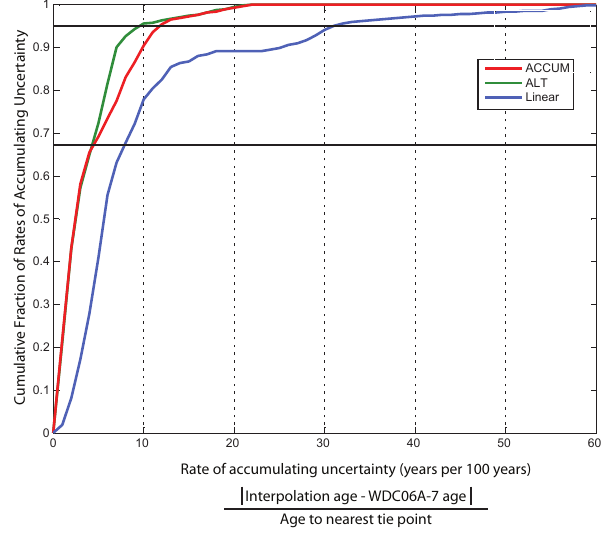
Figure 5. We define the rate of accumulating uncertainty as the absolute value of the age difference between an interpolation and the WDC06A-7 timescale at each WDC06A-7 age divided by the age difference from the nearest tie point. The cumulative fraction is the fraction of the total data set for which the rate of accumulat- ing uncertainty is below the threshold value on the x axis; this is similar to a cumulative distribution function. The horizontal lines indicate 0.68 (1 σ ) and 0.95 (2 σ )